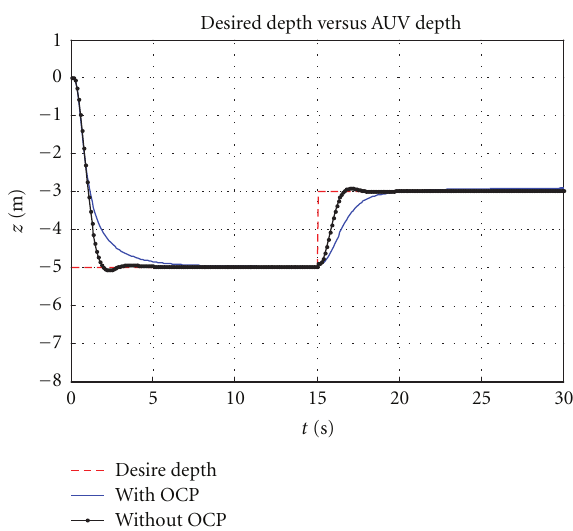
Figure 4: Depth control